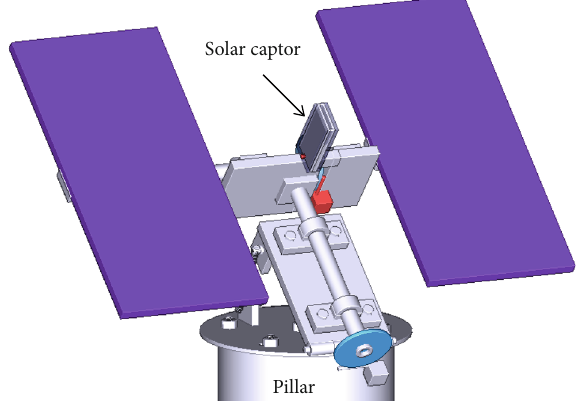
Figure 30: The solar tracker model with solar collector.